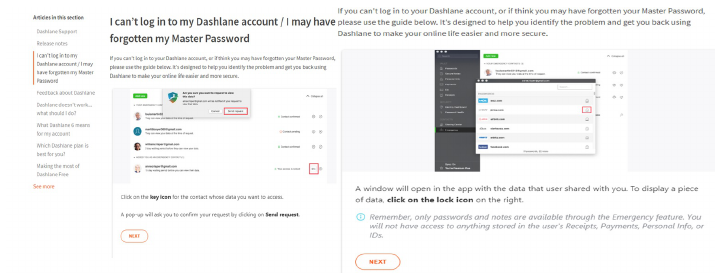
Figure A21. Recovering a Dashlane account requires a business team membership (not free).